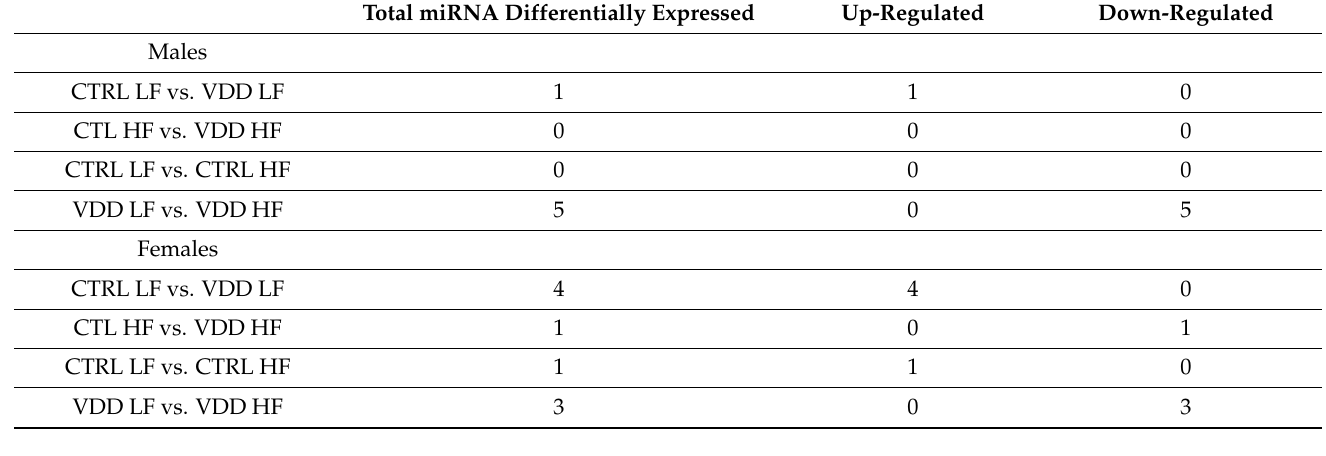
Table 2. The total number of differentially expressed miRNA that enters White adipose tissue